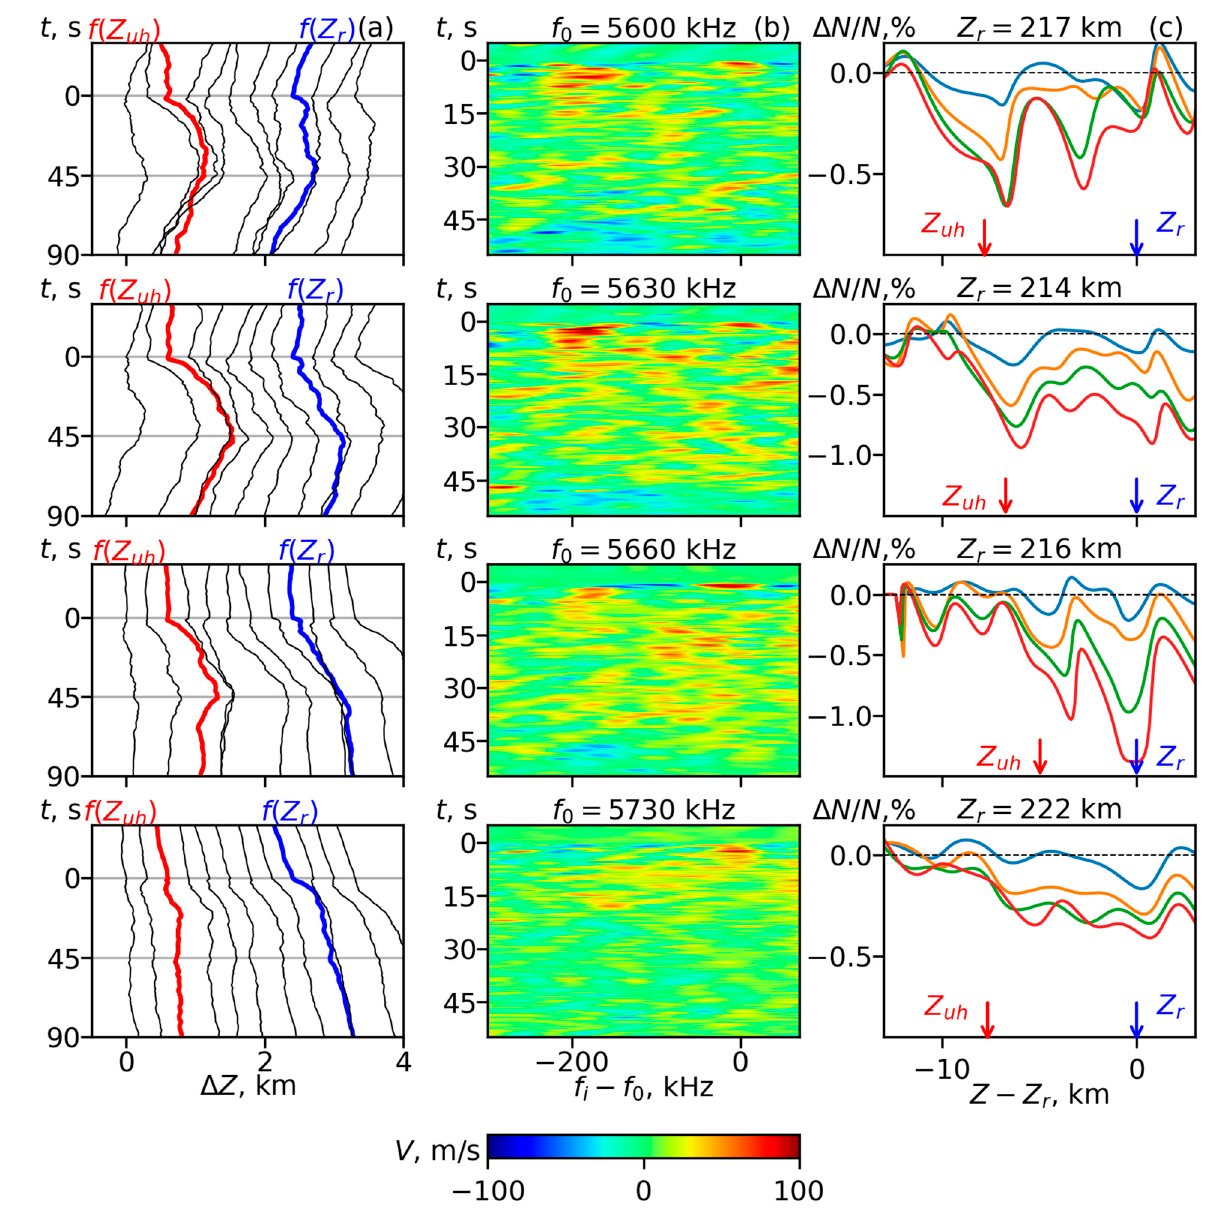
Figure 4. Results of the phase data processing for the PW reflection heights z r0 ≲ 220 km. The PW frequencies f 0 are shown above the ( b ) panels. Column ( a ): Temporal variations of the reflection height shifts of different spectral components of sounding pulses Δ z ( f i , t ) for different cycles. The frequency step between shown spectral components Δ f i = 60 kHz, starting from f 0 . An additional height shift of 300 m between the reflection heights of the successive shown frequencies f i at t = 0 was added for clarity. Red and blue lines correspond to the spectral components that were reflected from z UH and z r . Column ( b ): Velocity of the sounding waves reflection height displacement V v = ∂ Δ z r ( f i , t)/ ∂ t vs. time and frequency. Column ( c ): Relative variations of the electron density [ N ( t ) − N (0)]/ N (0) vs. height at t = 5 s (blue), 15 s (orange), 30 s (green) and 45 s (red) in the same cycles. Double arrows show the contaminated frequency range for the data processing.